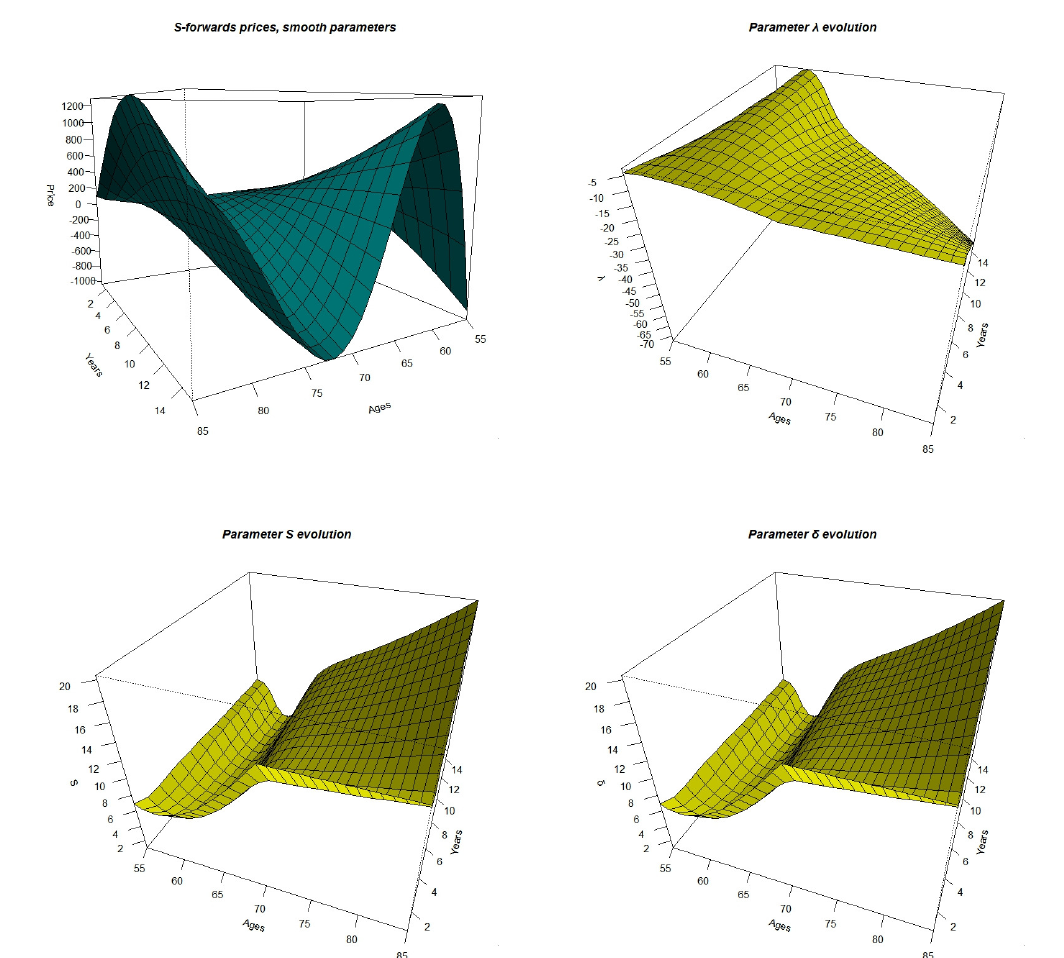
Figure A10. 3D presentation of the S-forwards prices and the corresponding parameters with the other